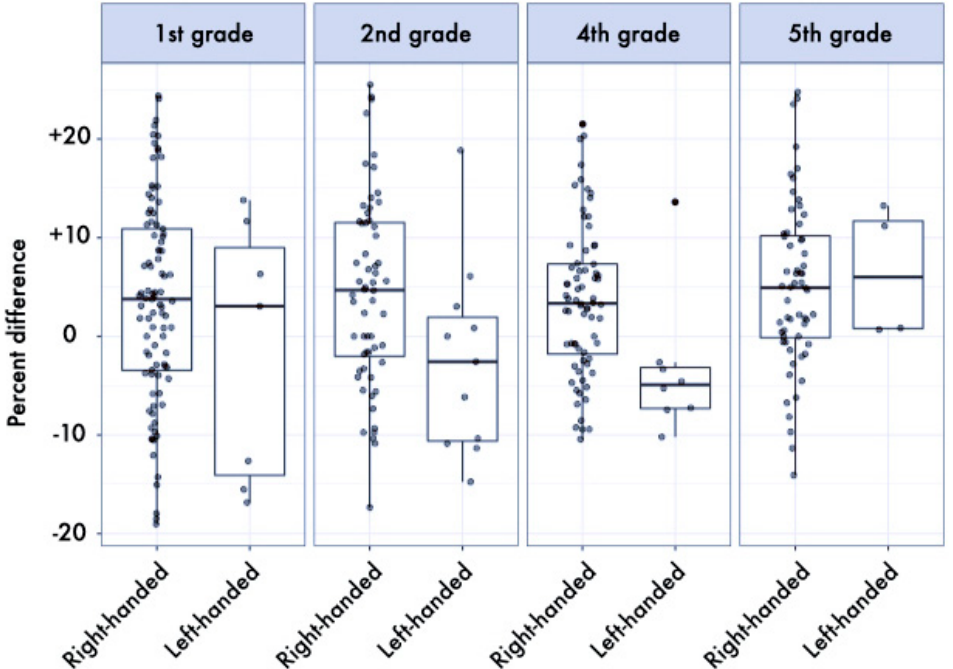
Figure 1. Boxplot (median and interquartile range, and individual values) of percent differences between dominant and non-dominant hand in the HS test stratified by school grade and hand preference. Values above 0% indicate better performance of the dominant hand. The median of the asymmetry index in favor of the dominant side was 2.63% for left-handed and 3.85% for right-handed children.